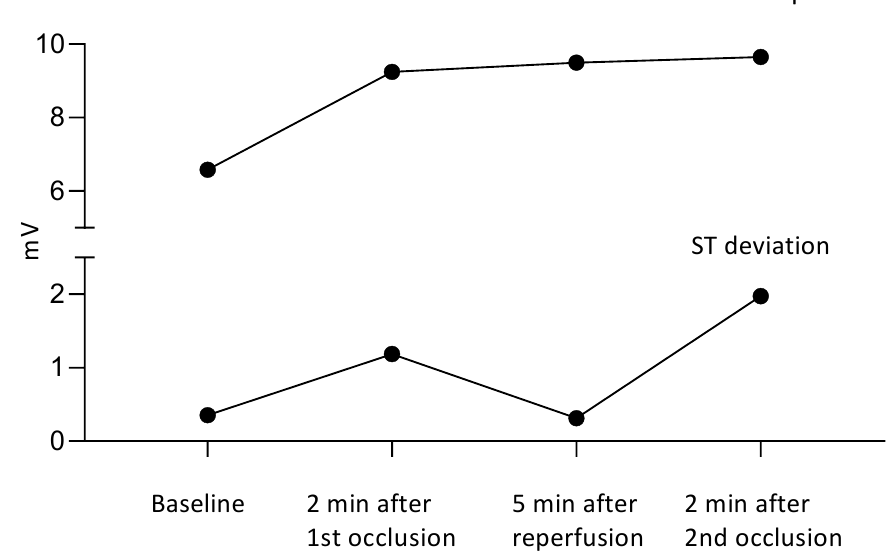
Figure 3. The sum of the ST deviations and T-wave Figure 3: The sum of the ST deviations and T-wave amplitudes The baseline sum of the T-wave amplitude was 6.58 mV, and two minutes into the first occlusion, the sum was 9.25 mV. Five minutes after the reperfusion, the sum of the T- wave amplitude changes was 9.50 mV, and two minutes into the second occlusion, the sum was 9.65 mV (Figure 3).